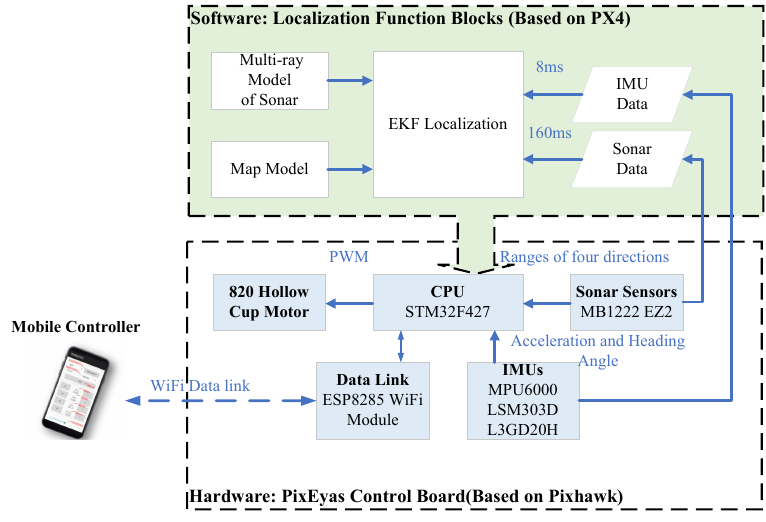
Figure 2. The system architecture of Thales II MAV